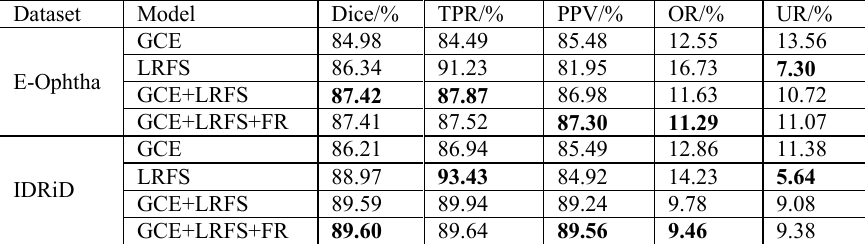
Table 1. Ablation experiment of